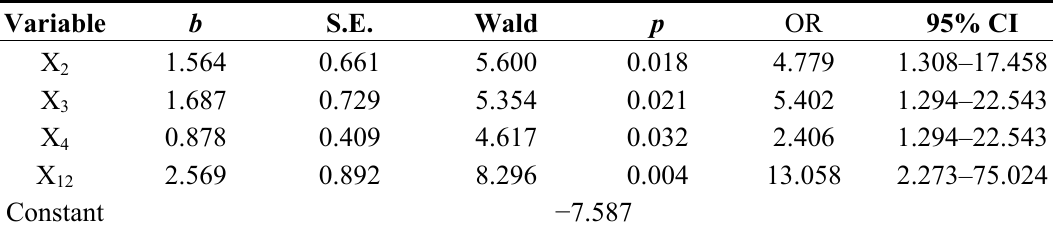
Table 4. Logistic-regression analysis of different parameters on non-alcoholic fatty liver disease (NAFLD)